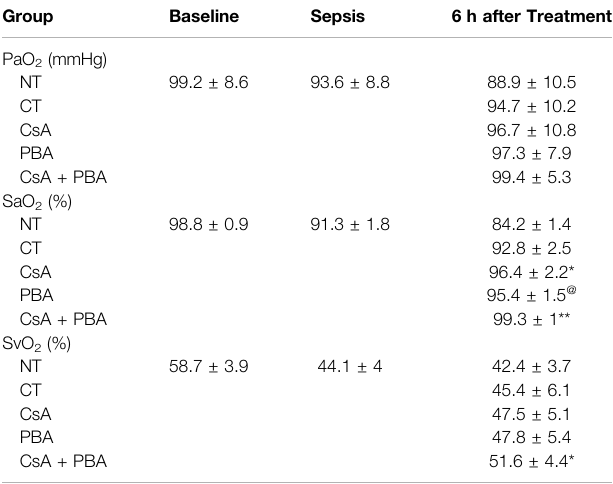
TABLE 1 | Synergetic effects of PBA + CsA on blood gas following sepsis. Group Baseline